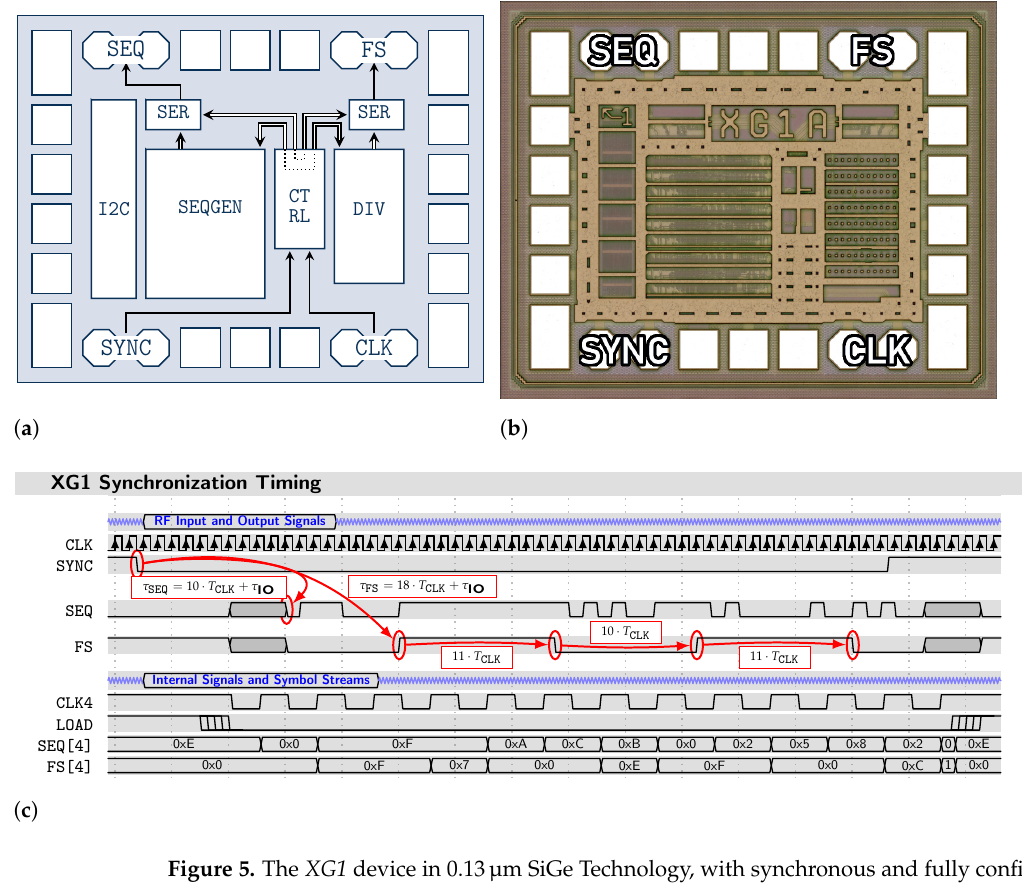
Figure 5. The XG1 device in 0.13µm SiGe Technology, with synchronous and fully configurable PRN sequence generator and one integer-S clock divider, designed for operation with f 0 of up to 30GHz. ( a ) Block diagram. ( b ) Die-shot with a total area of 0.80mm 2 . ( c ) Signal chart for S = f 0 / f S = 21, p ( x ) = x 12 + x 11 + x 7 + x 4 + 1 and starting vector 0xFFF0E, showing the synchronization to